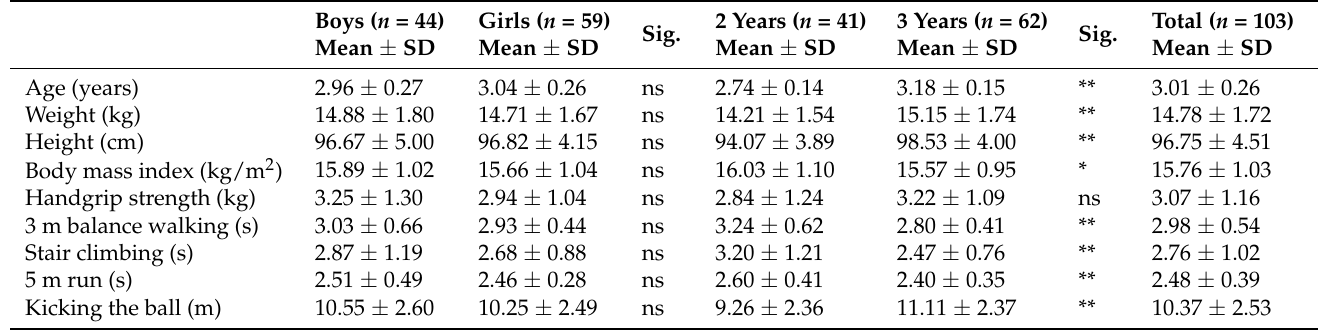
Table 1. Descriptive statistics of participants considering gender and age.